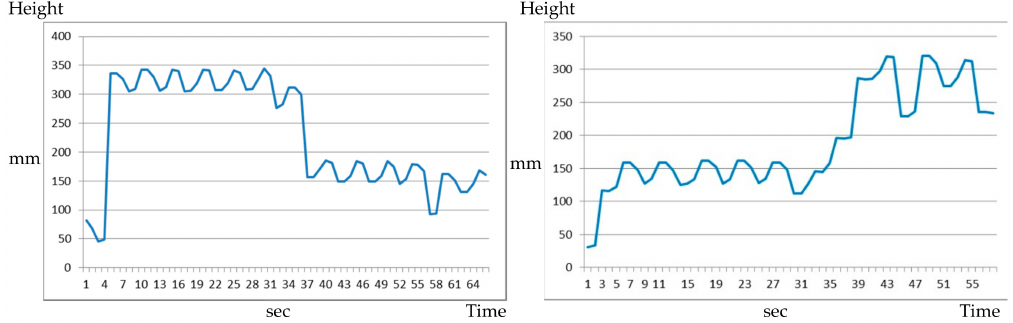
Figure 10. The case study evaluation: measuring robot determines higher stair first and then the smaller one at the left picture, and stairs at the right